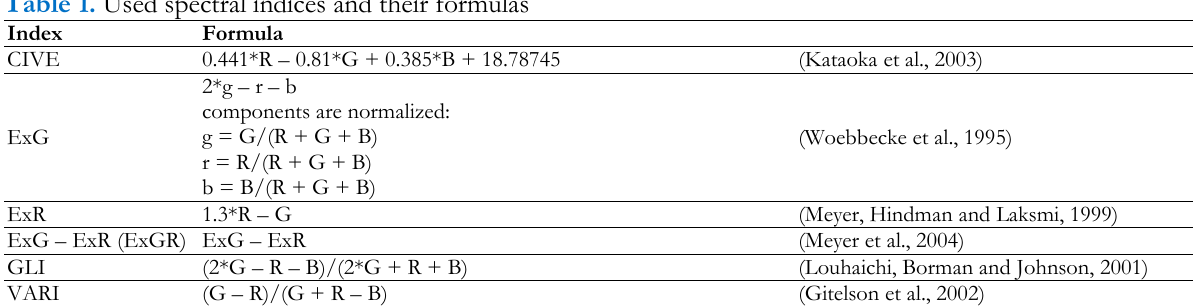
Table 1. Used spectral indices and their